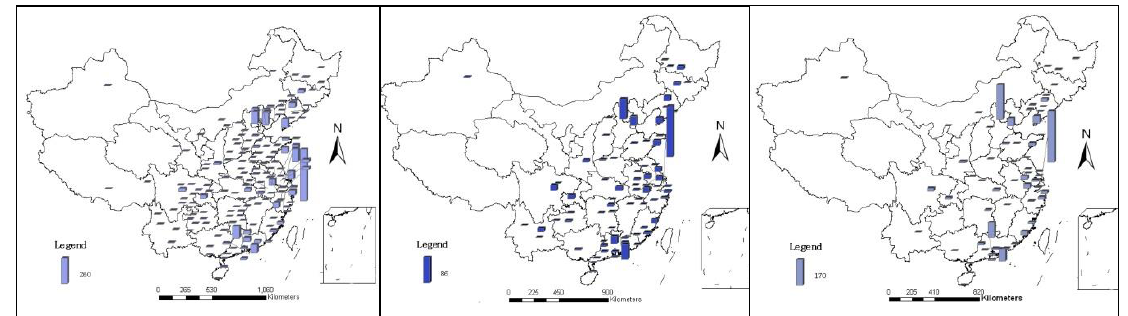
Figure 3: Spatial Distribution of Production Facilities (Left) and Sales and Marketing Offices (Center) and Business Services